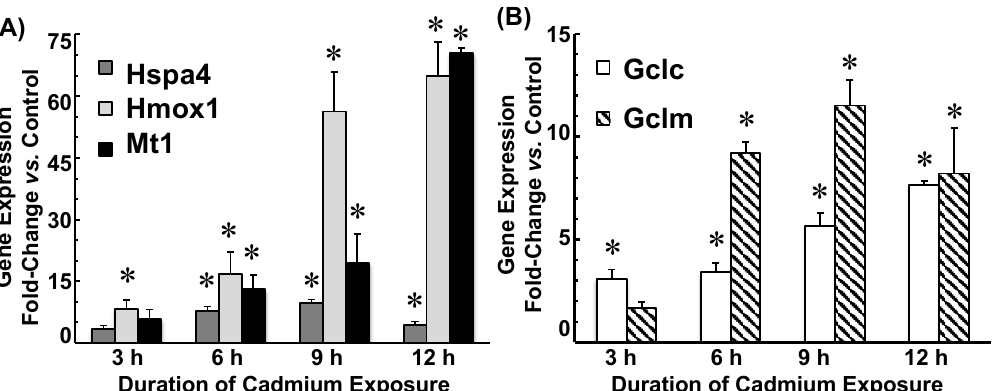
Figure 2. Time-dependent gene expression for rat heat shock protein-70 (Hspa4), heme oxygenase-1 (Hmox1), and metallothionein (Mt1) ( A ) and for GCLC (Gclc) and GCLM (Gclm) ( B ) in choroid plexus epithelial cells (CPECs) exposed to 500 nM CdCl 2 . Non-zinc supplemented CPECs were pre-treated (12 h) in serum-free medium (SFM) and then divided into two sets: one set was incubated for 12 h in SFM without CdCl 2 (Control), while the other was exposed for 12 h to 500 nM CdCl 2 in SFM (Cd). All treatments were performed at 37 °C. At 3, 6, 9, and 12 h, representative cadmium-exposed and time-matched control cells were collected for analysis of mRNA expression by quantitative real-time polymerase chain reaction (qRT-PCR); mRNA expression for each test gene was normalized to mRNA for rat β -actin (Actb) and GAPDH (Gapdh). Fold-induction was calculated as the ratio of normalized gene expression in Cd-exposed cells to that in time-matched controls. mRNA was analyzed in triplicate in five separate culture preparations. Data are means ± SE; n = 5; * p < 0.05 vs. time-matched Control.